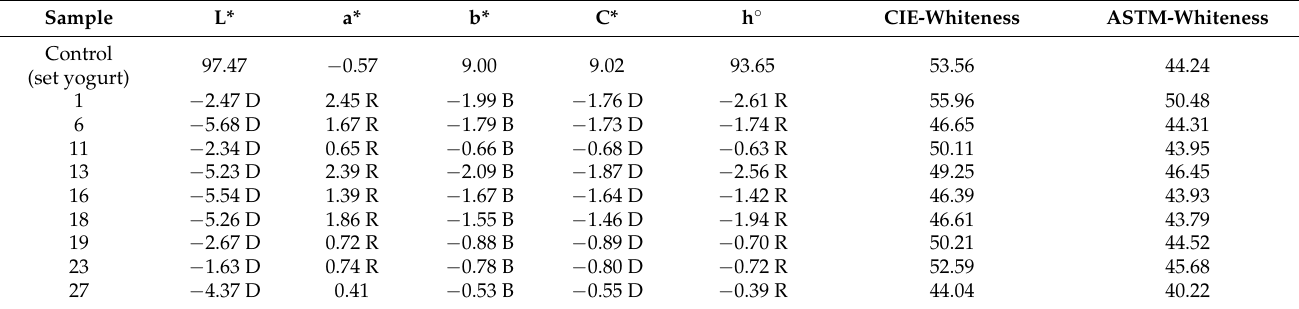
Table 2. Effects of different extracts on the color parameters and whiteness of yogurt. R stands for “redder”; B stands for “bluer”; D stands for